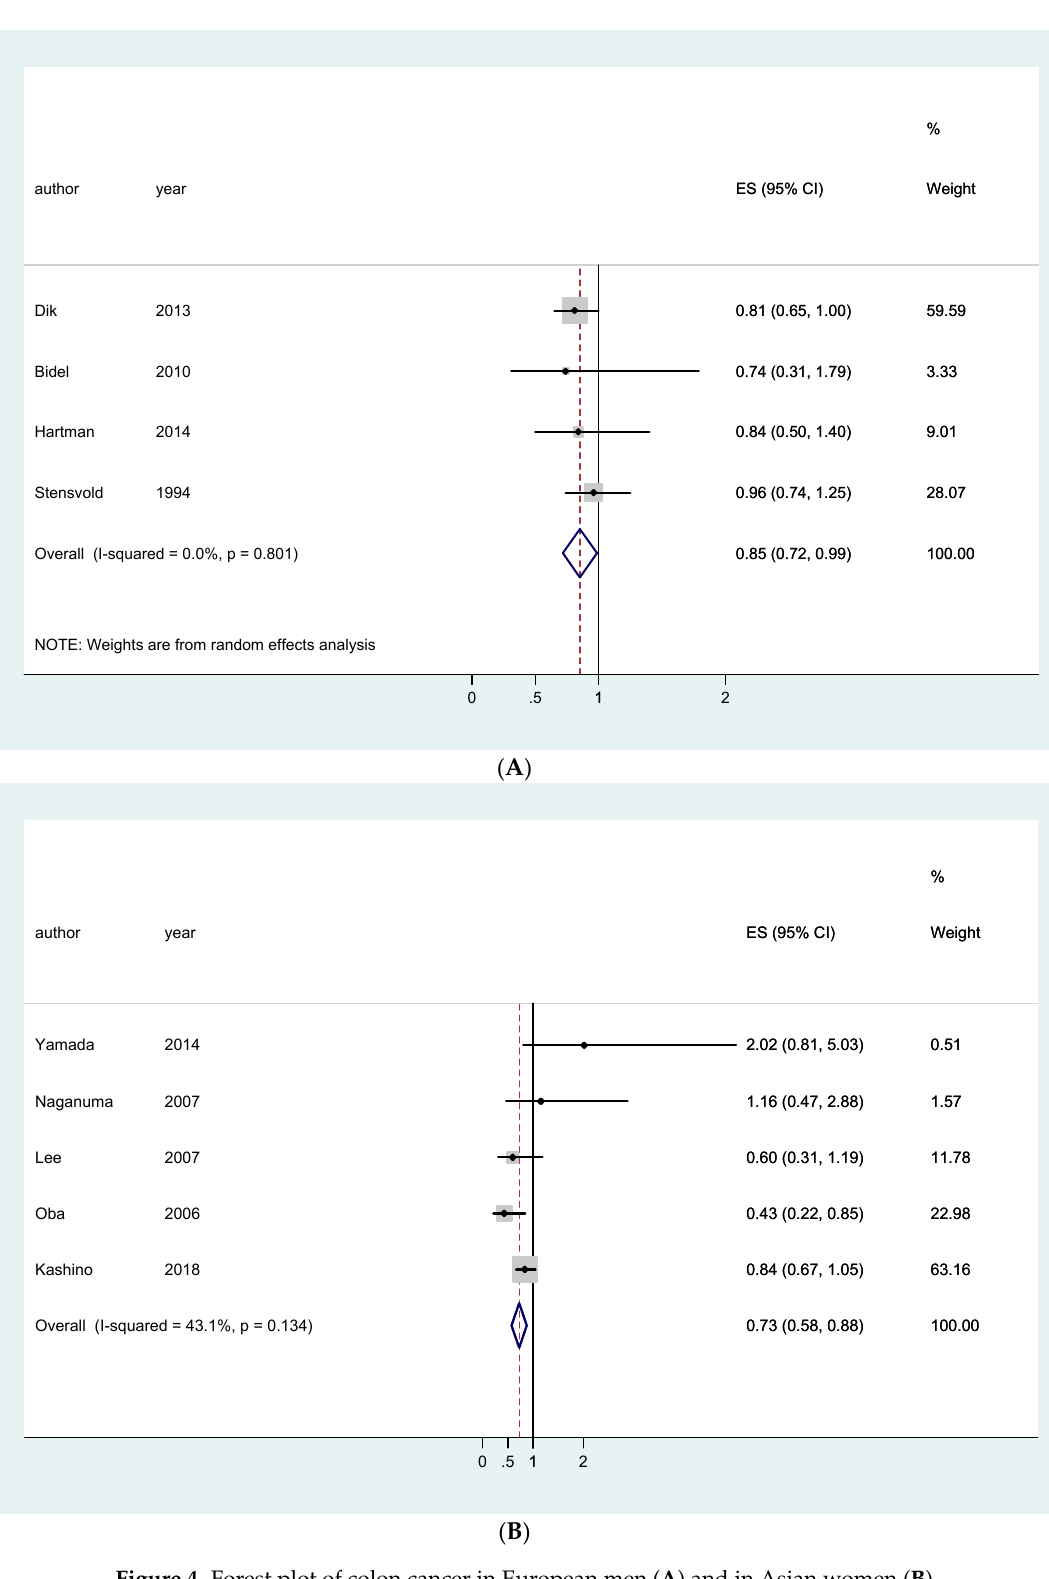
Figure 4. Forest plot of colon cancer in European men ( A ) and in Asian women ( B ). Focusing on distal colon cancer (Table 3), coffee consumption proved protective in European men only (RR 0.77 (95% CI 0.57–0.98)). With regard to proximal colon cancer (Table 3), no significant association was